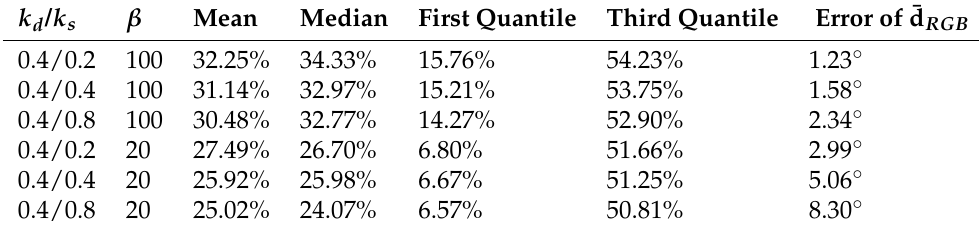
Table 2. Evaluation of the improvement for different